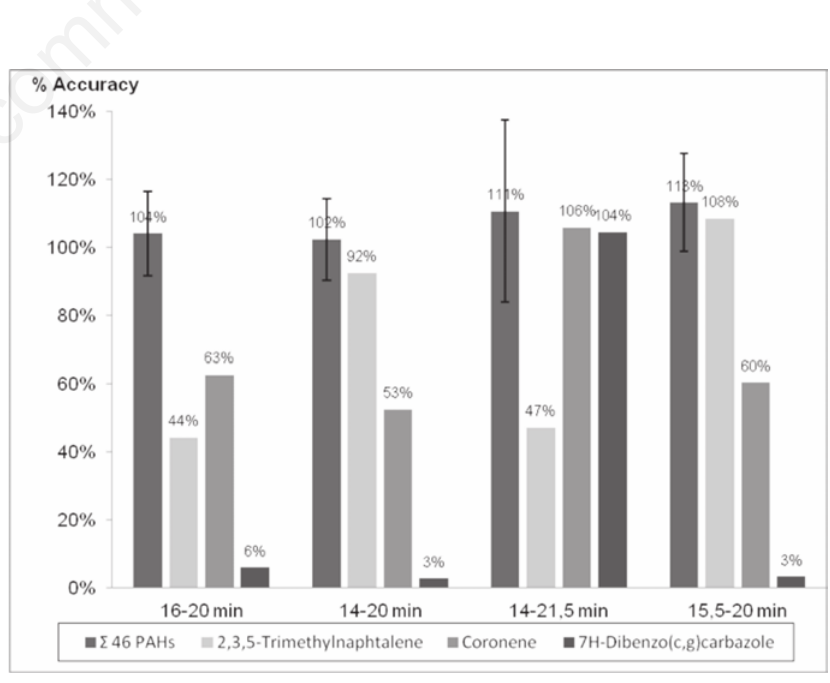
Figure 1. Accuracy percentage of the targeted polycyclic aromatic hydrocarbons (PAHs) for the four